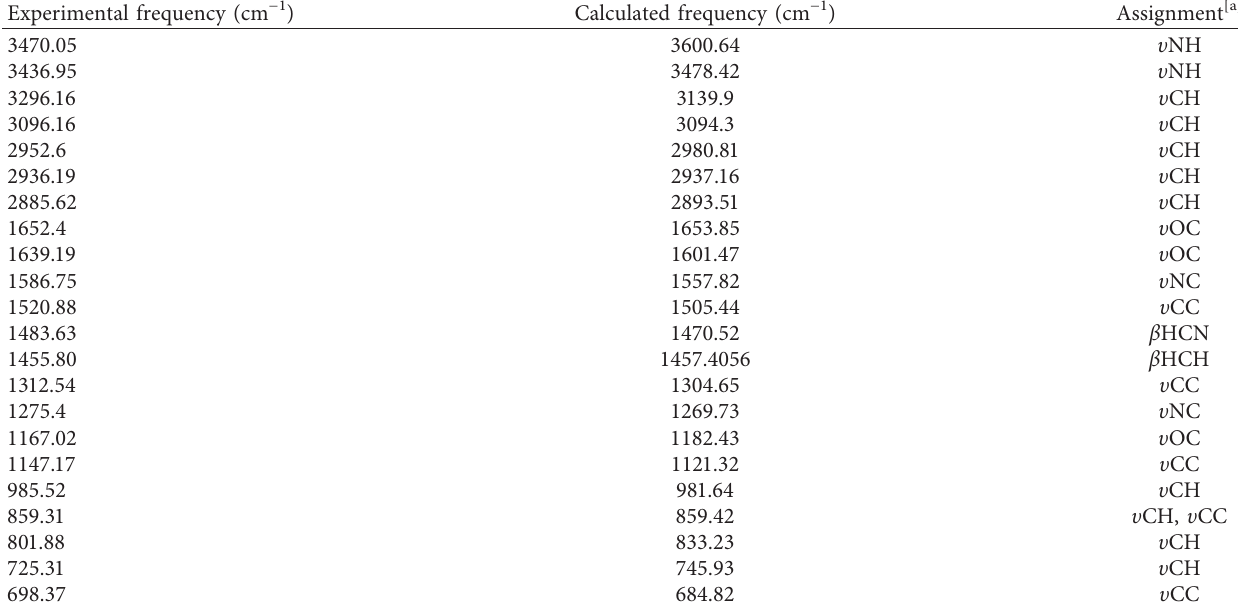
Table 1: The main experimental and calculated vibrational frequencies (in cm − 1 ) and their assignments and contribution for Iibrutinib molecule based on the density functional theory computations at the B3LYP level of theory and 6-311G++(d,p) basis sets. Experimental frequency (cm − 1 ) Calculated frequency (cm − 1 ) Assignment [a] 3470.05